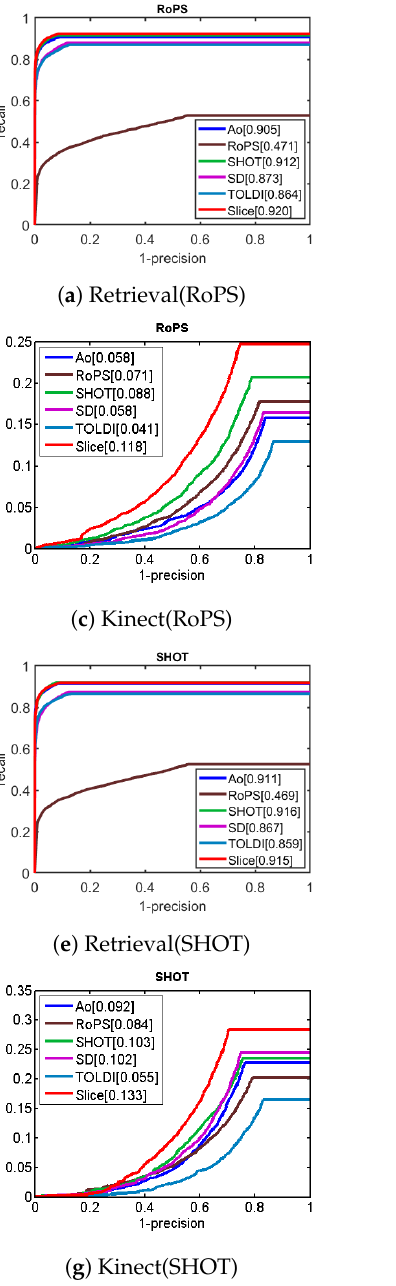
Figure 12. The descriptor matching experiment results. Rows 1–2 use the RoPS descriptor, and rows 3–4 use the SHOT descriptor. The number in the legend is AUC PR